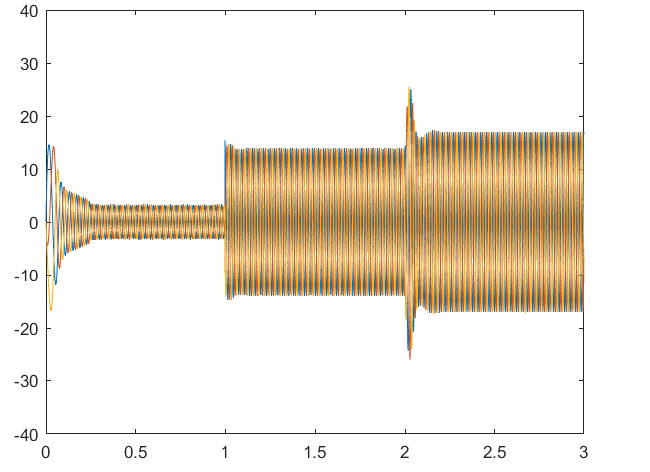
Figure 11. Stator currents under variation 50% of J.